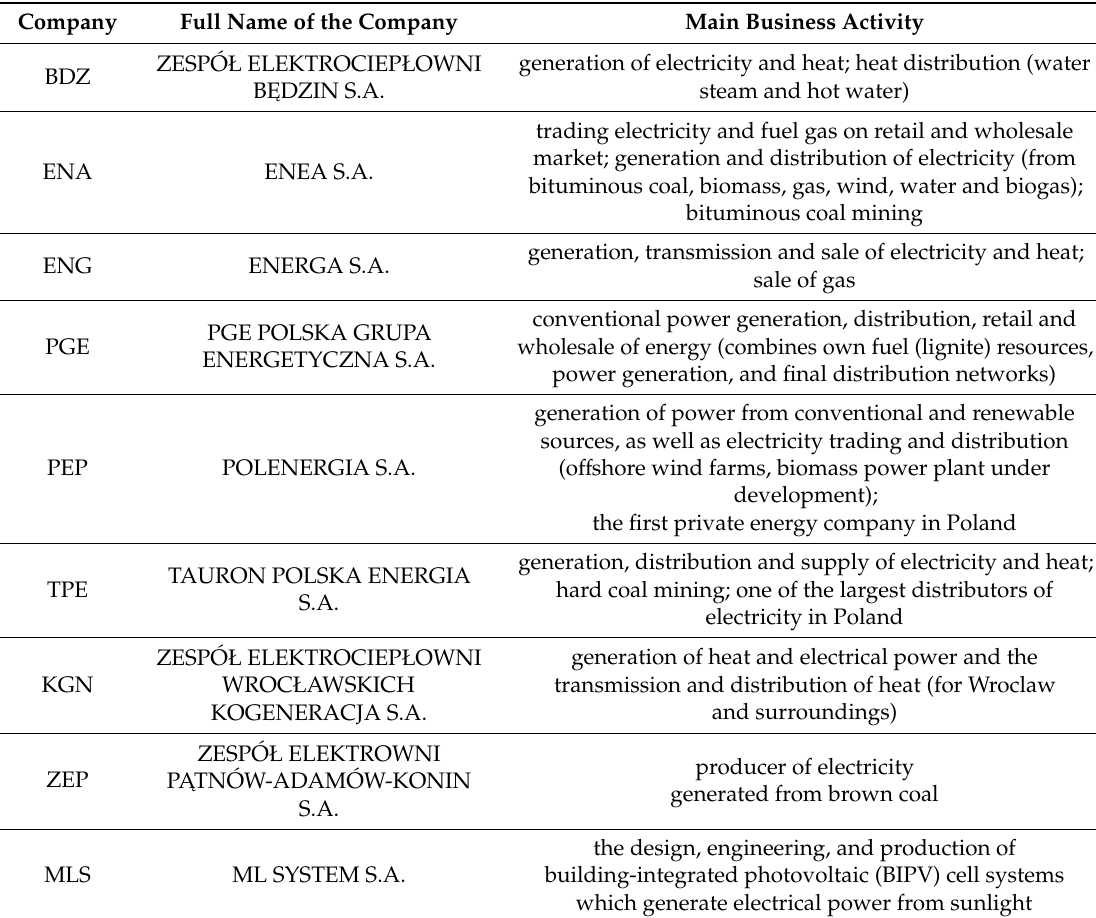
Table 1. Companies included in the research